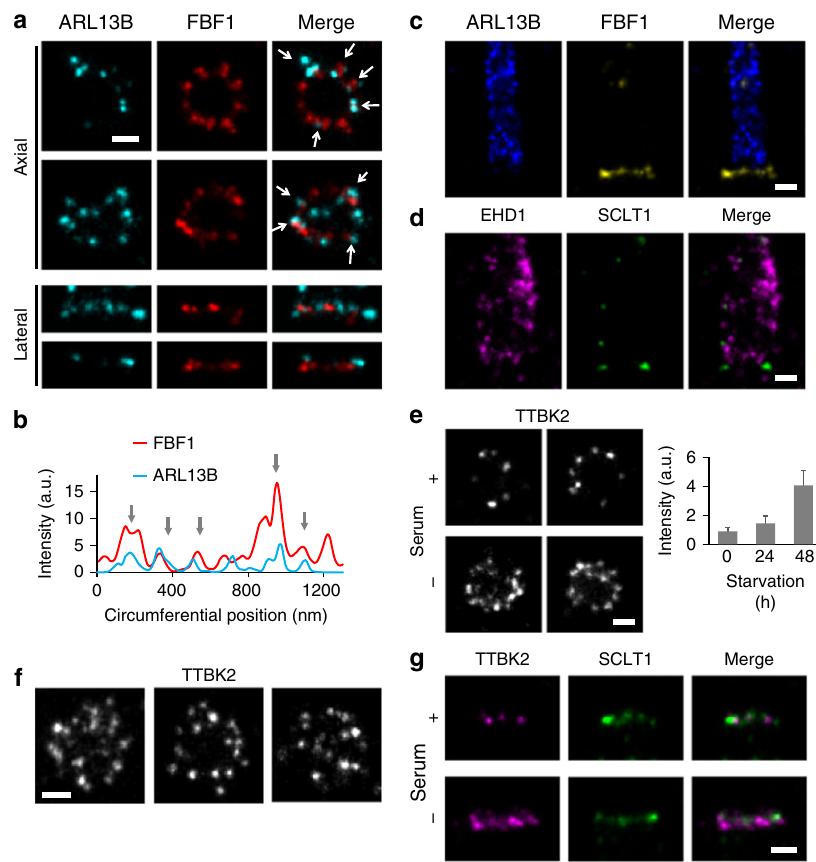
Fig. 4 Localization of other DAP-related proteins ARL13B, EHD1, and TTBK2. a During the early stages of cilia growth, ARL13B is located adjacent to FBF1 (arrows), as con fi rmed by correlation analysis in b . c ARL13B becomes localized to cilia during or after ciliogenesis with an exclusion zone approximately at the proximal transition zone. d The vesicle-forming protein EHD1 is localized to a peripheral region wider than that of ARL13B, presumably on the membrane of the ciliary pocket. Axial e , f and lateral g views of the distribution of TTBK2 with and without serum, showing a broader and more enriched TTBK2 distribution in both radial and longitudinal directions after serum starvation. Results are presented as mean ± SD of 24, 20, and 23 centrioles for 0, 24, and 48 h, respectively. Bars = 200